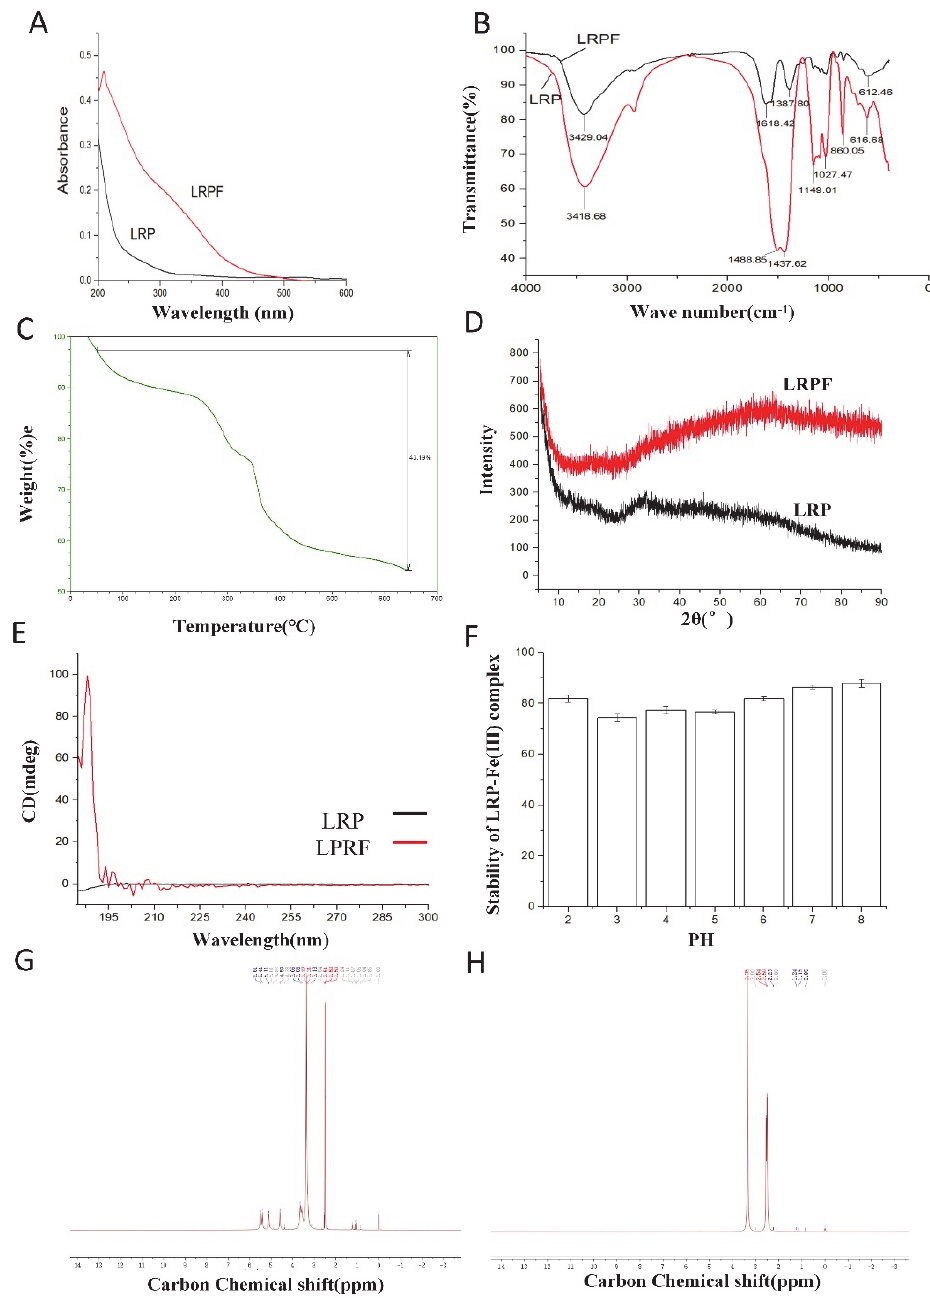
Figure 2. Characterization of LRP and LRPF. ( A ) Ultraviolet spectroscopy of LRP and LRPF. ( B ) FT-IR spectrum of LRP and LRPF. ( C ) Thermogravimetric spectrum of LRPF. ( D ) X-ray diffraction spectrum of LRP and LRPF. ( E ) Circular dichroism spectrum of LRP and LRPF. ( F ) The stability of LRPF in vitro. ( G ) 1 H NMR spectra of LRP. ( H ) 1 H NMR spectra of LRPF.